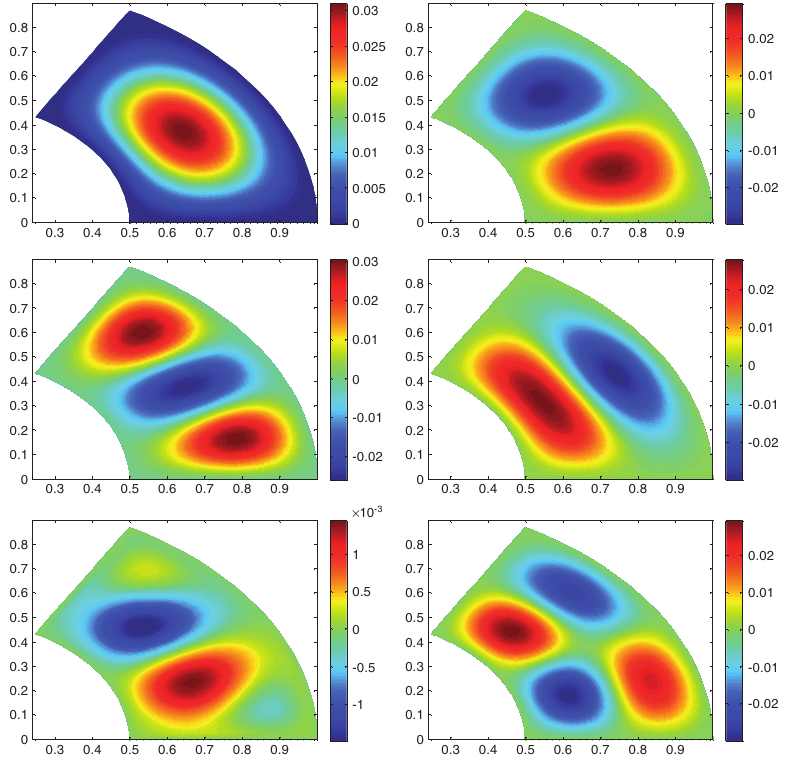
Figure 3 The first six mode shapes of a fully clamped isotropic FG annular sector plate for n = 1 and θ = 60 °